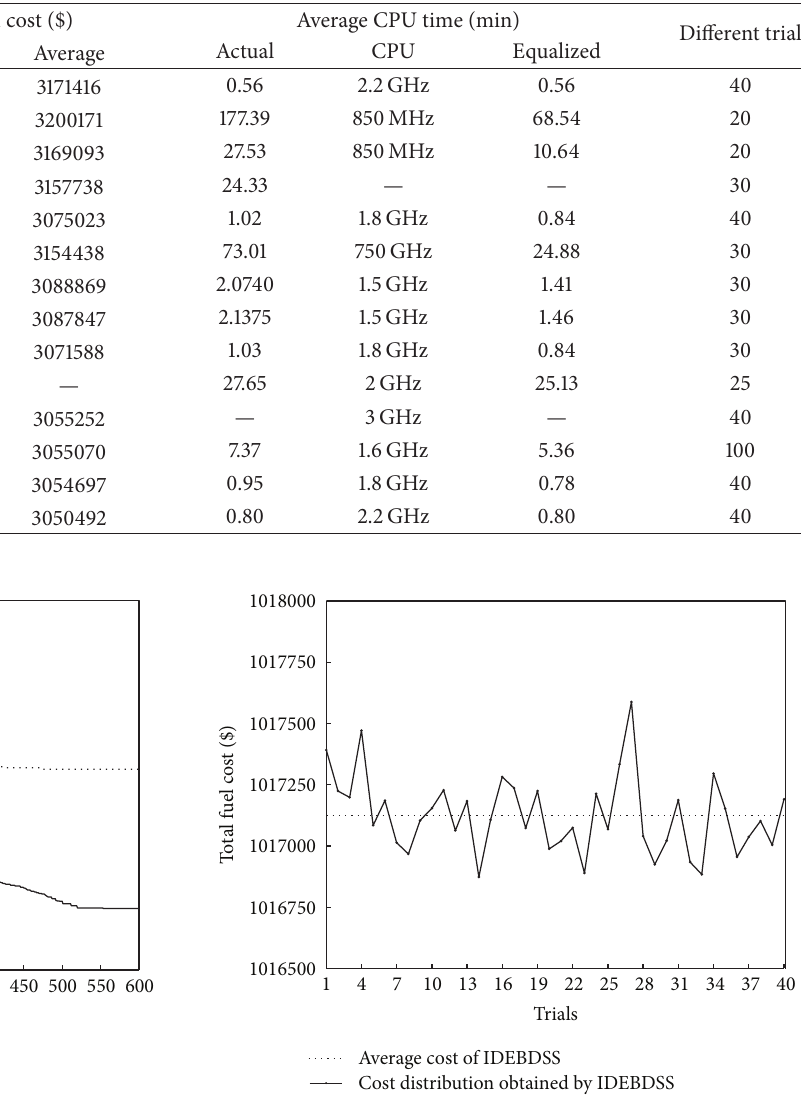
Figure 5: Cost distribution obtained by IDEBDSS for test system